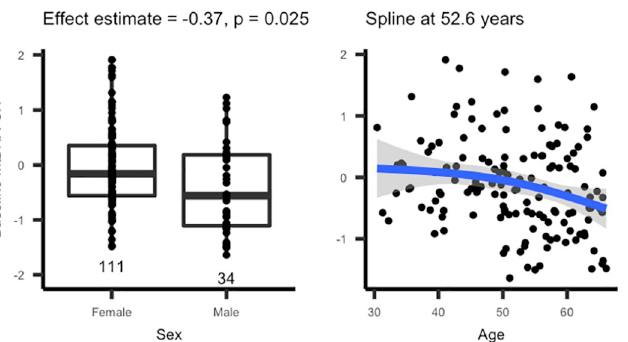
Fig 1. Associations between baseline mtDNA-CN and known covariates. Baseline mtDNA-CN is associated with age and sex in the expected directions. Females have higher baseline mtDNA-CN, and baseline mtDNA-CN decreases with